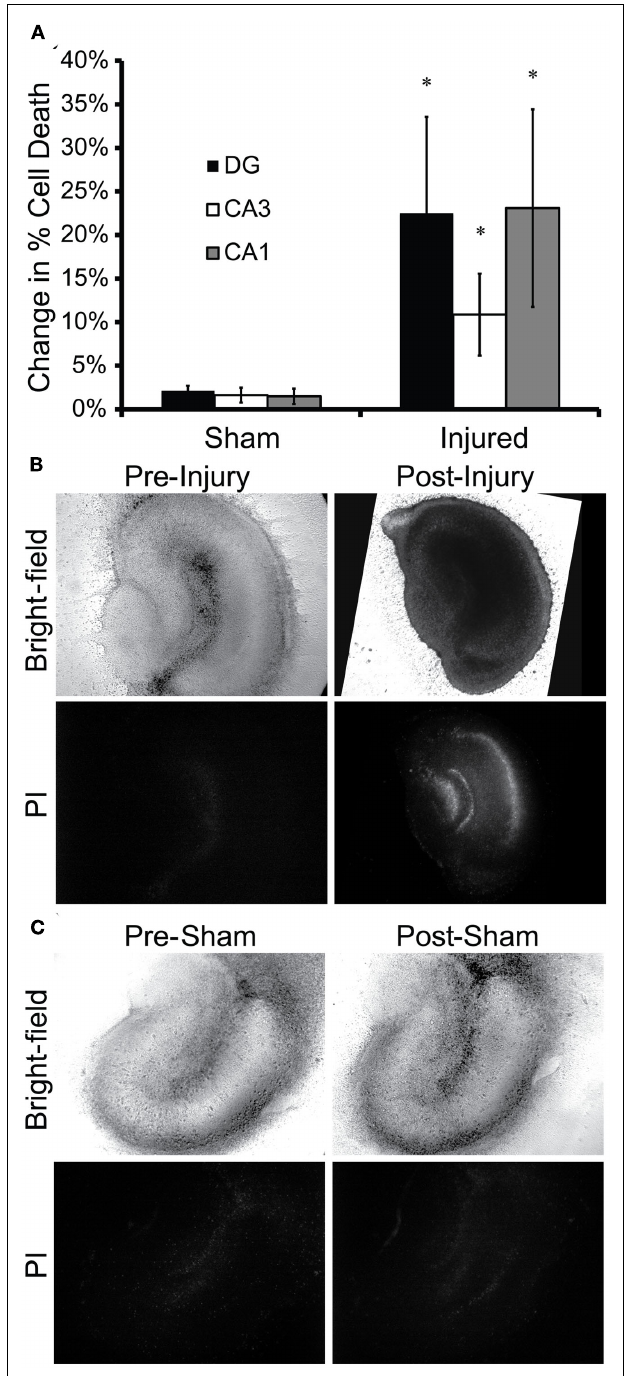
FIGURE 4 | In vitro blast injury of OHSC. OHSC were exposed to 530 ± 17.7kPa peak incident overpressure, 1.026ms duration ± 0.017ms, and 190 ± 10.7kPa-ms impulse in-air. (A) Injured OHSC experienced increased cell death 4days following blast. Cell death increased significantly in all regions of injured OHSC as compared to sham-exposed OHSC (* p < 0.05; SEM; Sham n = 21; Injured n = 13). (B) Bright-field and fluorescent images of injured tissue revealed significant PI staining 4days following injury. (C) Sham-exposed cultures maintained normal morphology with minimal cell death over the 4-day period following